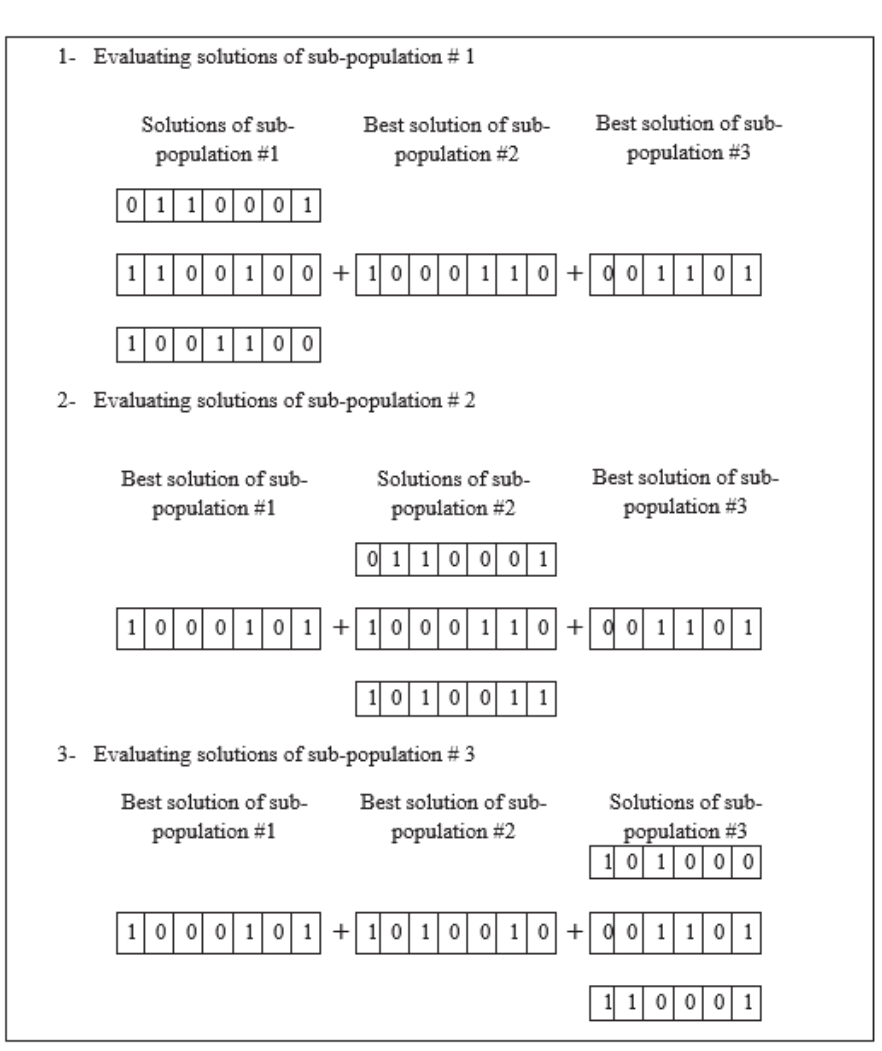
Figure 5. PartialSolutions evaluation of all sub-population as FullSolutions .